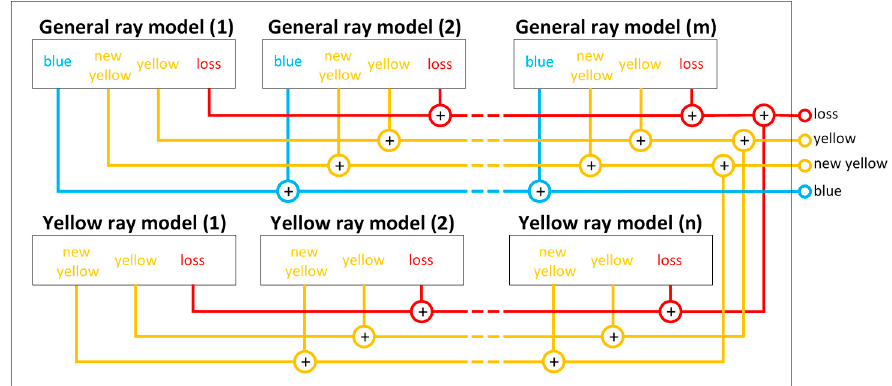
Figure 17. Structure of the phosphor cell model. The number of general and yellow ray models can be different.